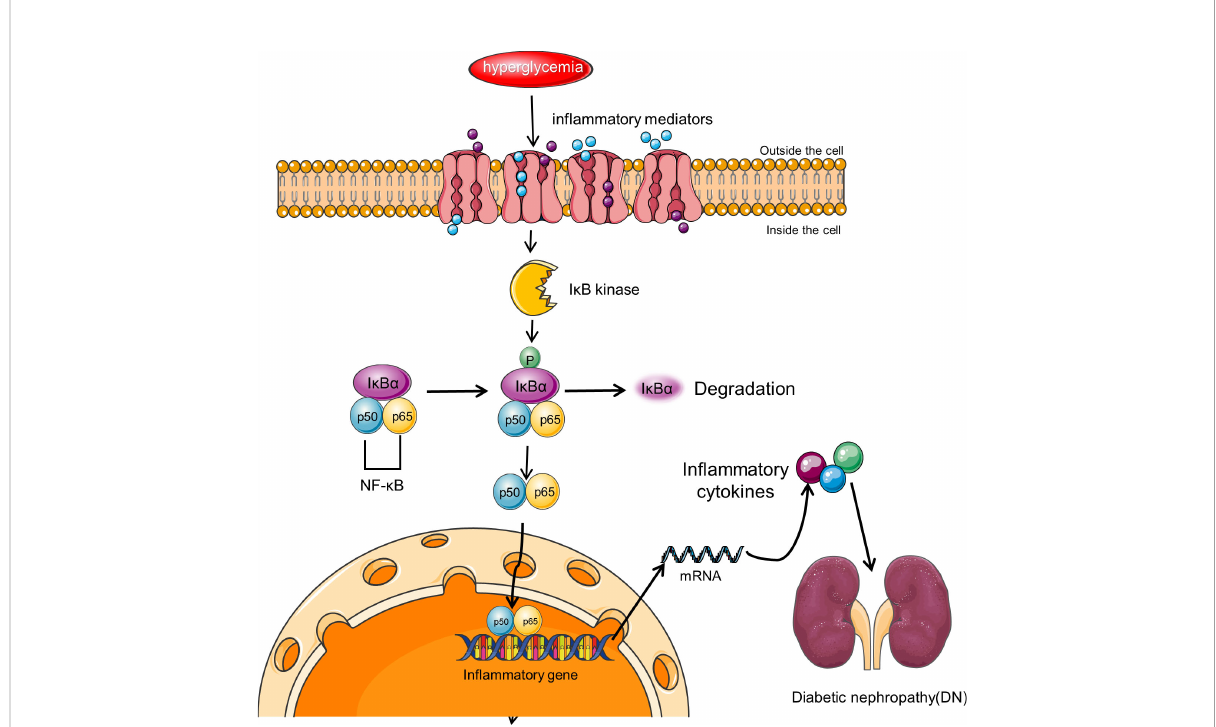
FIGURE 3 NF- k B signaling pathway in DN. NF- k B is a transcriptional regulator expressed in the cytoplasm of almost all cell types, and its activity is controlled by the I k B regulatory protein family. Activation of NF- k B involves the inhibitory protein I k B kinase being phosphorylated by speci fi c I k B and subsequently degraded by proteolysis. Free NF- k B translocates to the nucleus, binds to promoter and enhancer sites, and activates transcription. NF- k B signaling pathway leads to increased transcription of target genes encoding in fl ammatory cytokines and other target genes associated with this complication, resulting in renal in fl